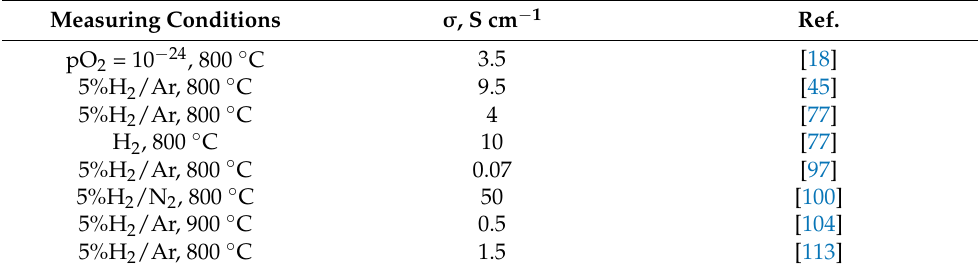
Table 5. Conductivity of Sr 2 MgMoO 6- δ . These data are also presented in Figure A2.